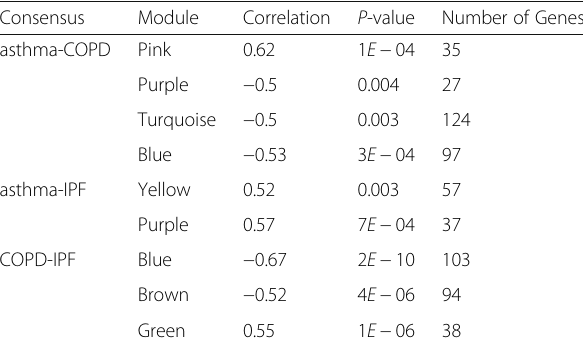
Table 4 Module-trait Association Analysis Modules, Consensus Modules Derived from COPD, IPF, and asthma